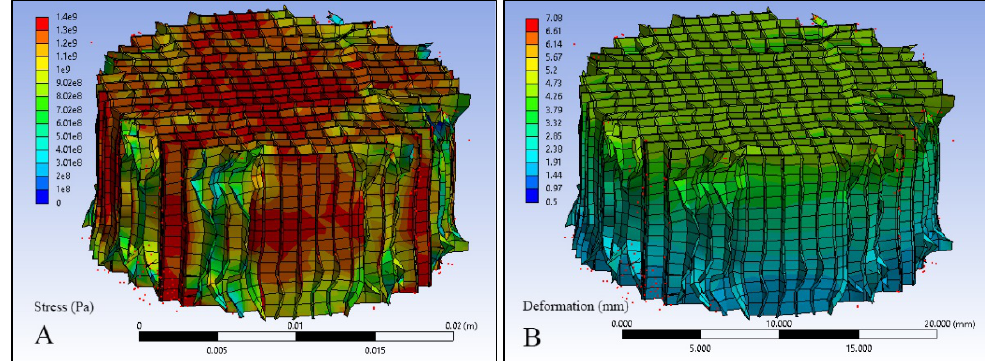
Figure 3. Rectangular scaffold simulation: ( A ) Stress and ( B ) displacement (final height after compression: 15 − 4.26 = 10.74 mm; red dots are separated particles in contact with compressive punches).